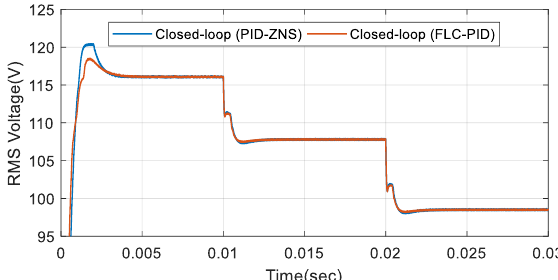
Fig.10: RMS output voltage for proposed ESU with PID-ZNS and FLC-PID